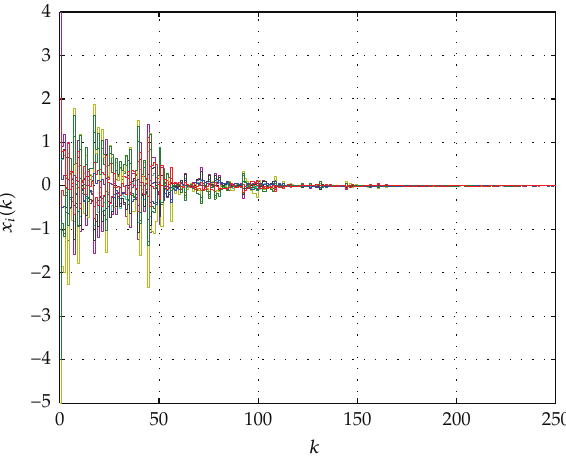
Figure 4: State responses with C1-2 (Example 10).